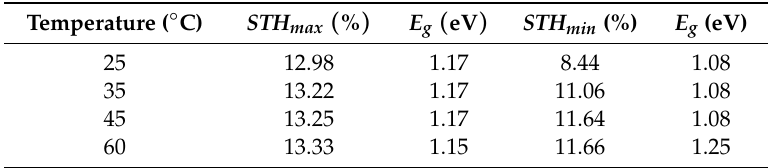
Table 2. The highest and the lowest STH e ffi ciencies for (A)CIGS–NiMo–NiO solar water splitting systems together with corresponding E g of (A)CIGS modules for di ff erent temperature of the NiMo–NiO